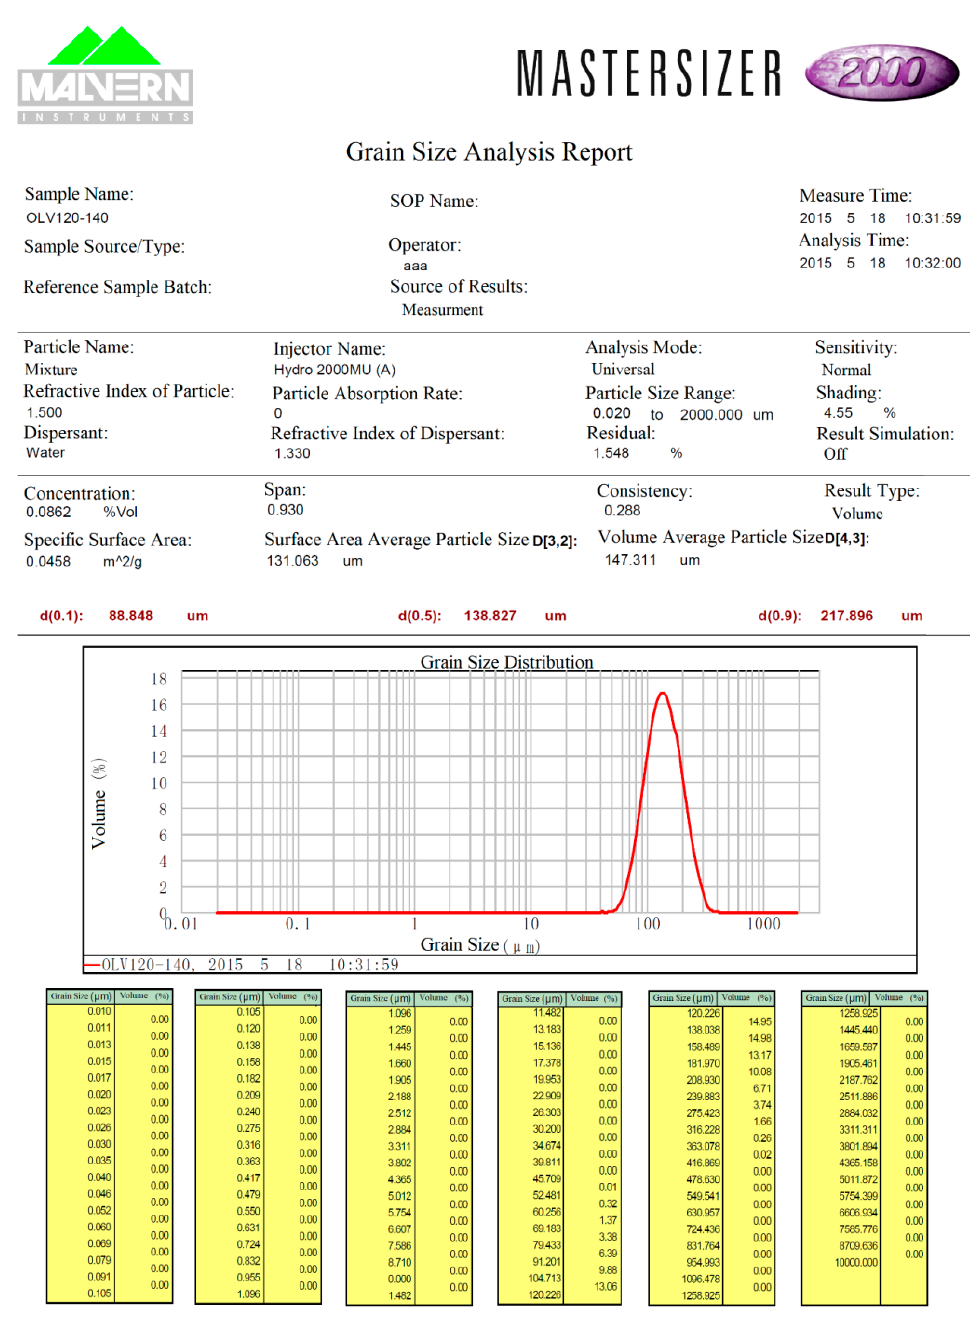
Figure 2. The grain size analysis report of olivine.